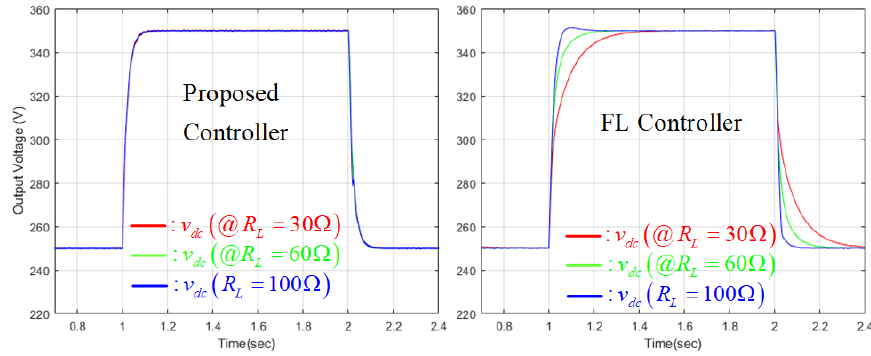
Figure 5. Output voltage tracking performance change behaviors for R L = 30,60,100 Ω .